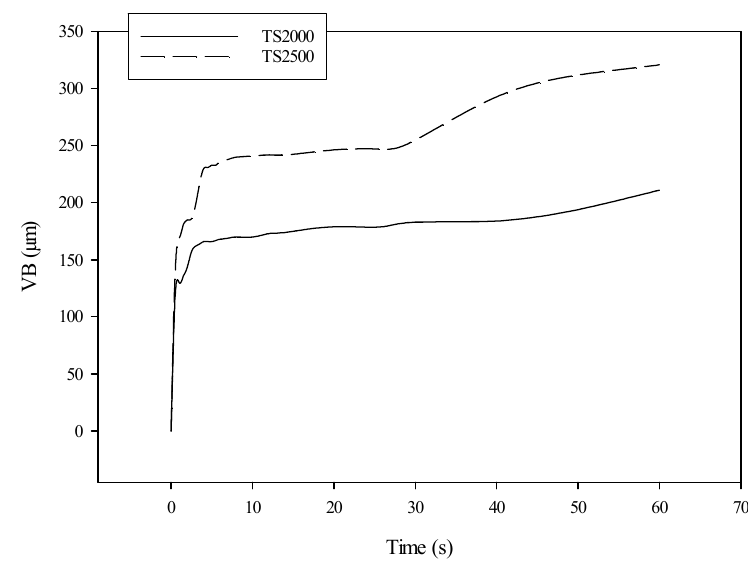
Figure 5. Wear modes in both inserts after 60 s of cutting.